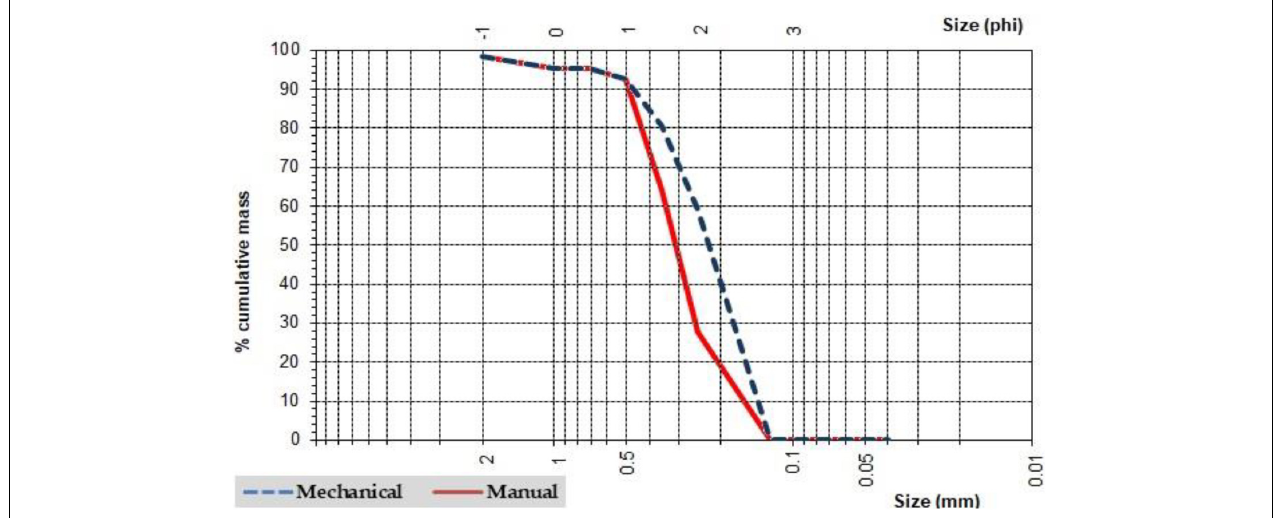
FIGURE 4 | Comparison of the granulometric curves of sand sample 17 (particle size in mm and phi units) for both mechanical and manual sieving.